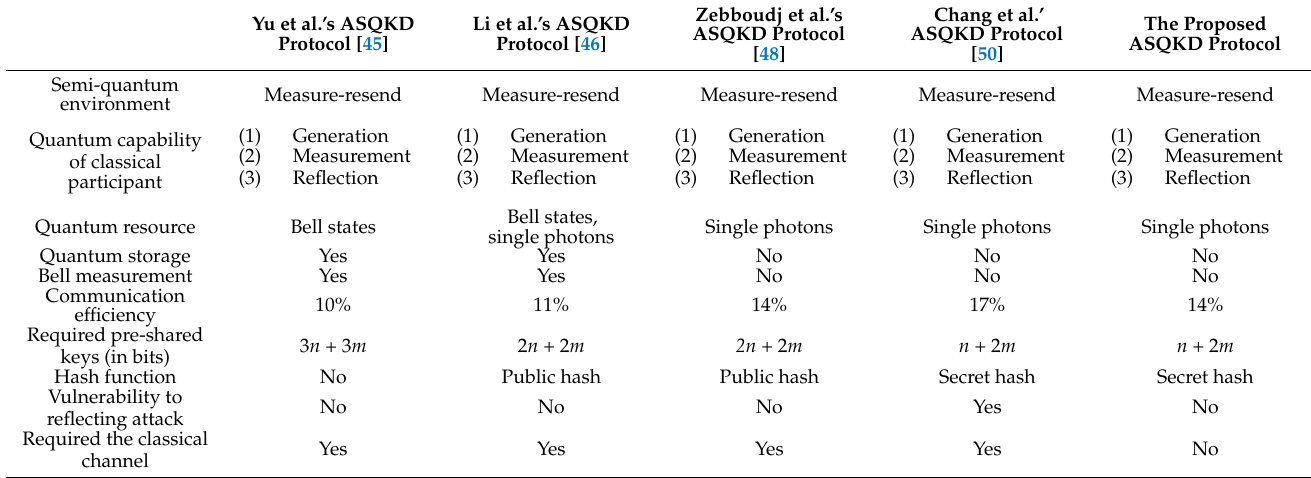
Table 1. Comparison of [45,46,48,50] and the proposed ASQKD